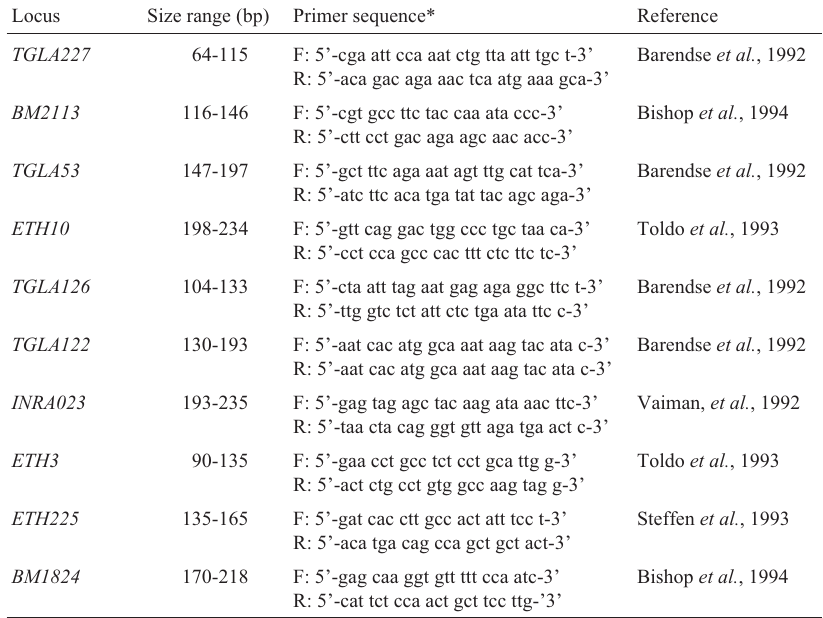
Table 1 - Details of the ten microsatellite loci